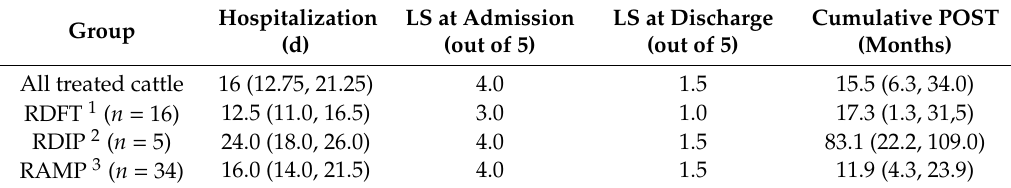
Table 1. Median duration of hospitalization after surgery, locomotion score (LS) at admission and discharge and cumulative POST of cattle in the three treatment groups (1st and 3rd